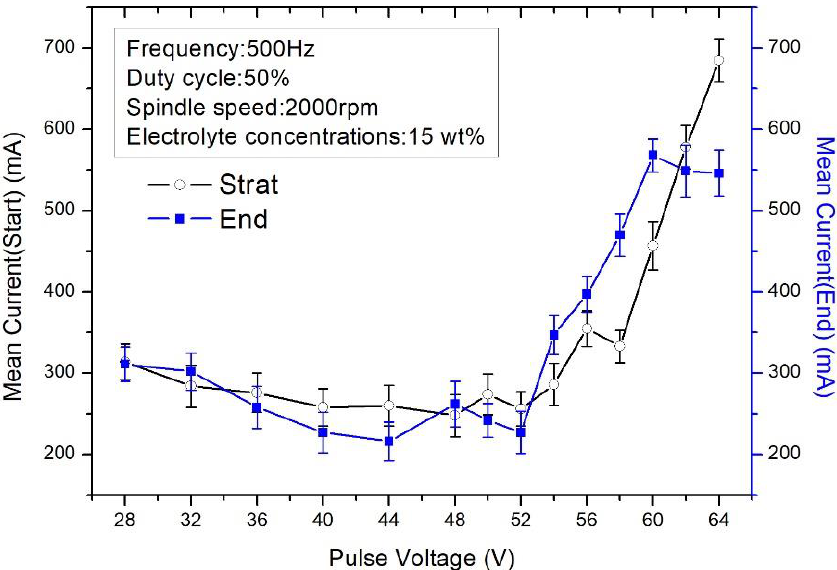
Figure 8. Relationship between the voltage and average current of the spark discharge before and after machining.